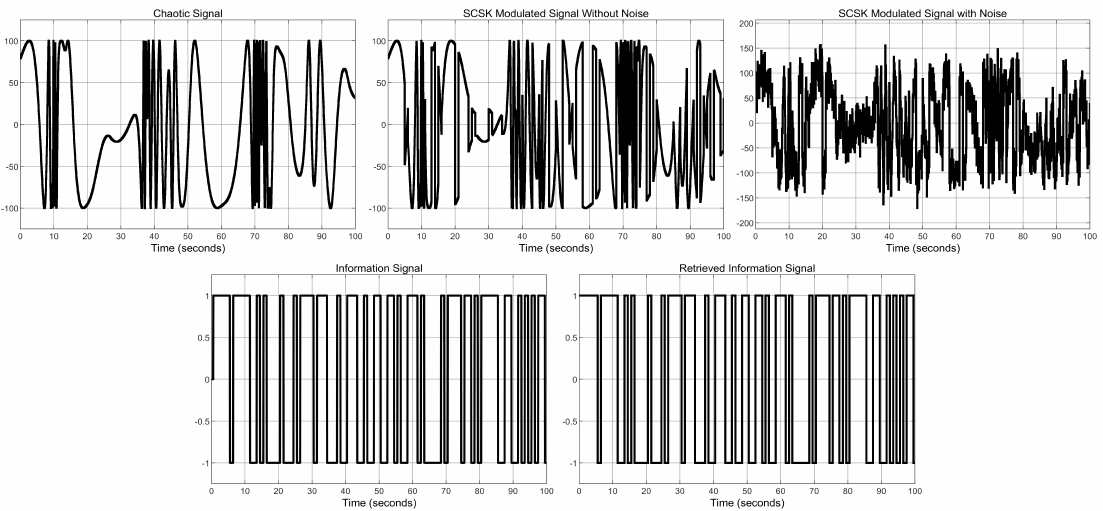
Figure 12. Simulation results of the SCSK secure communications design, for chaotic signal 100 · sin3 ( x + y + z ) .